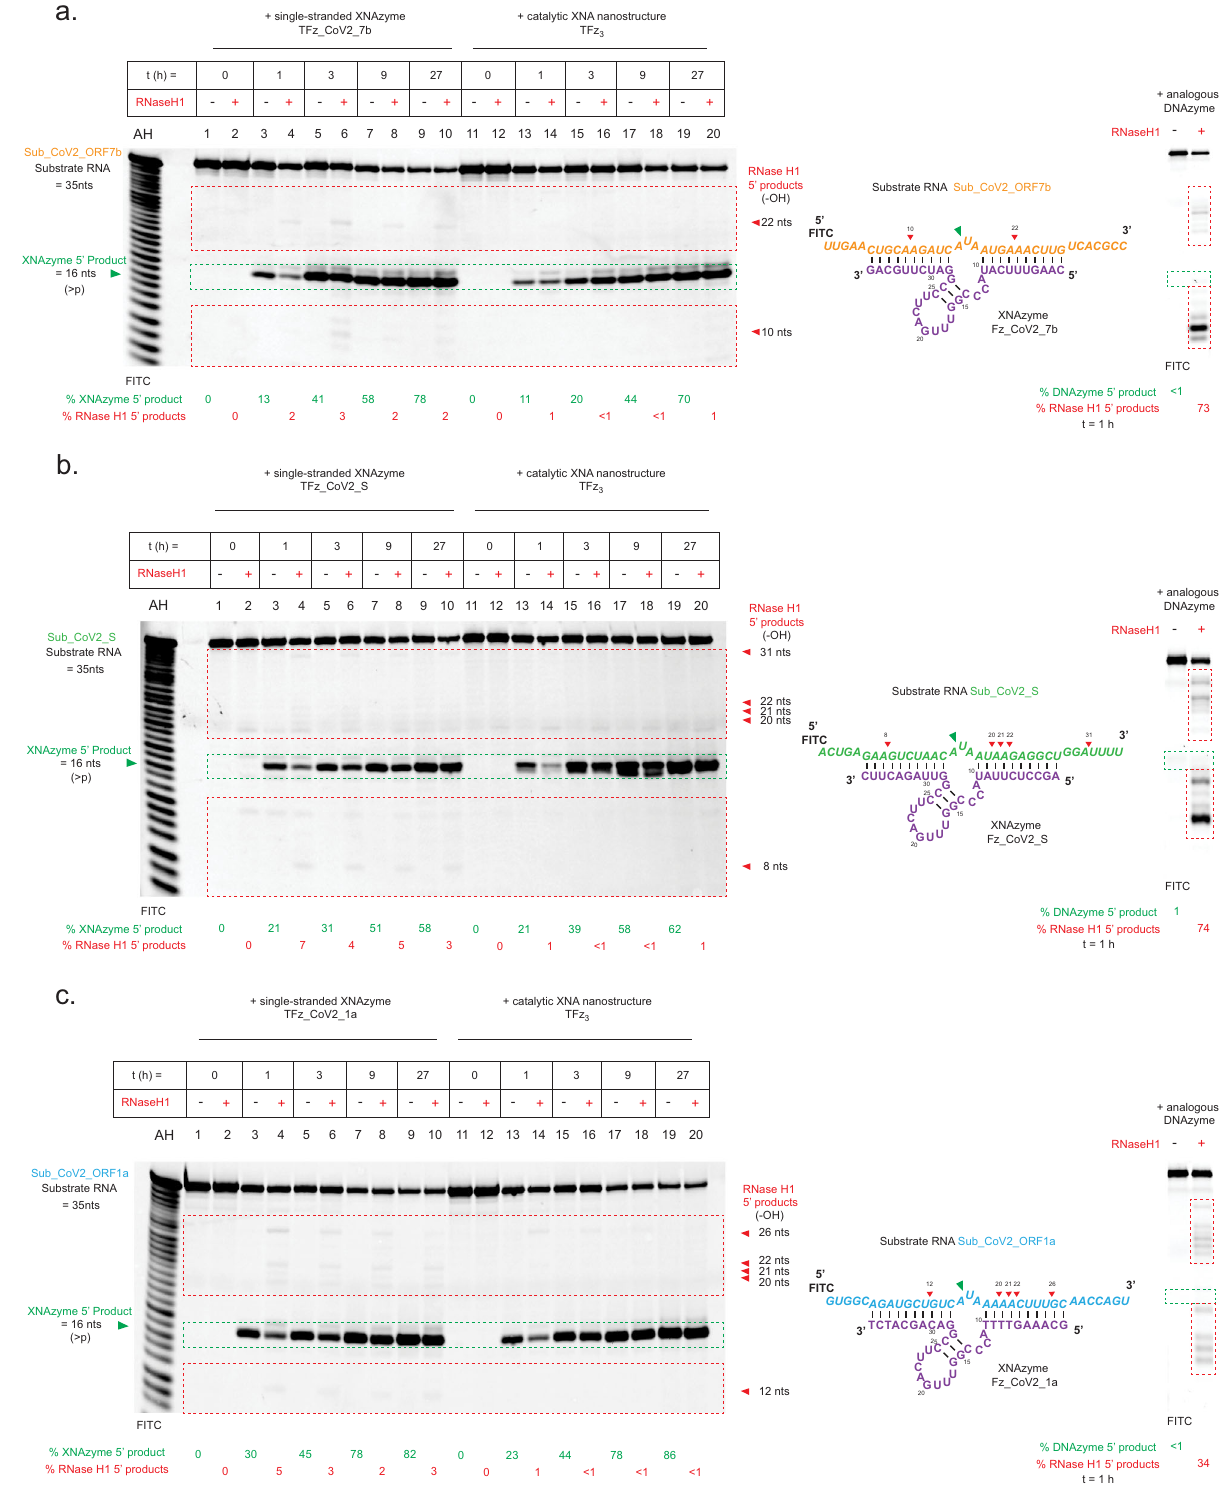
Fig.4 | Assembling XNAzymes intoacatalyticXNAnanostructurelimitsRNase H1-mediated RNA cleavage. a – c Urea-PAGE gels showing human RNase H1 assays and schematics showing deduced RNA products and cleavage sites mediated by RNase H1 (indicated by red dotted line boxes and red arrows) or mediated by XNAzyme catalysis (indicated by green dotted line boxes and green arrows). Human RNase H1 was incubated with (0.25 μ M) RNA substrates ( a ) Sub_- CoV2_ORF7b, ( b ) Sub_CoV2_S or c Sub_CoV2_ORF1a, and either (0.25 μ M) single- stranded component XNAzymes, puri fi ed fully-assembled nanostructure (TFz 3 ) or